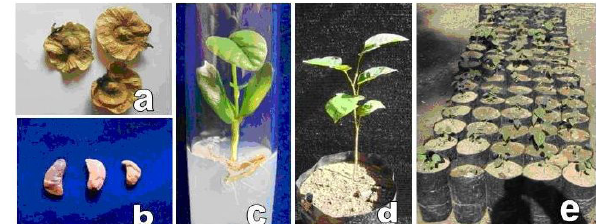
Fig. 1. In vitro seed germination of Pterocarpus marsupium (a) seed pods with orbicular wing; (b) true seeds excised from the pod; (c) seedling emerged from seed inoculated in horizontal orientation; (d) seedling transferred to polythene bag (e)